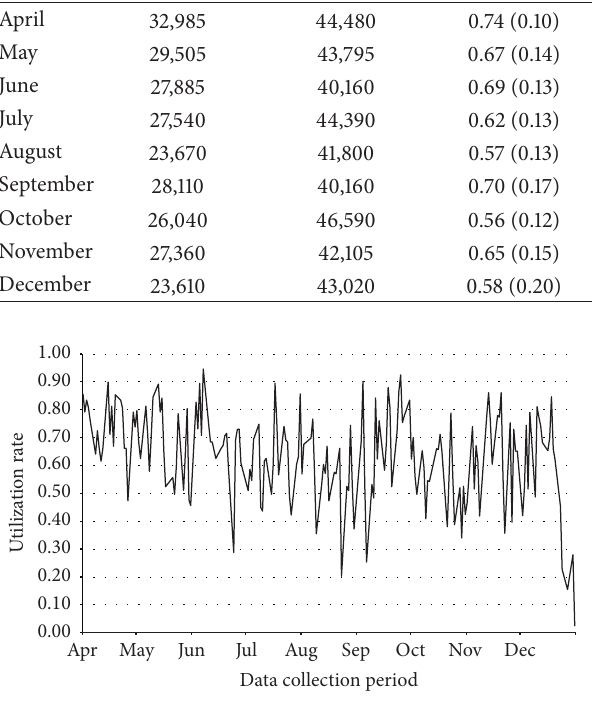
Figure 1: Daily utilization rates.